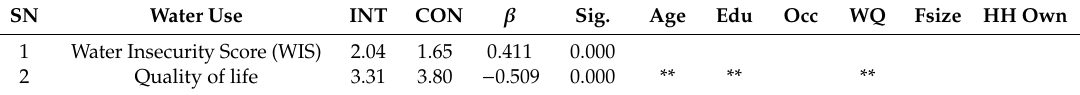
Table 3. Water insecurity and quality of life (QoL) perception in the pre-intervention